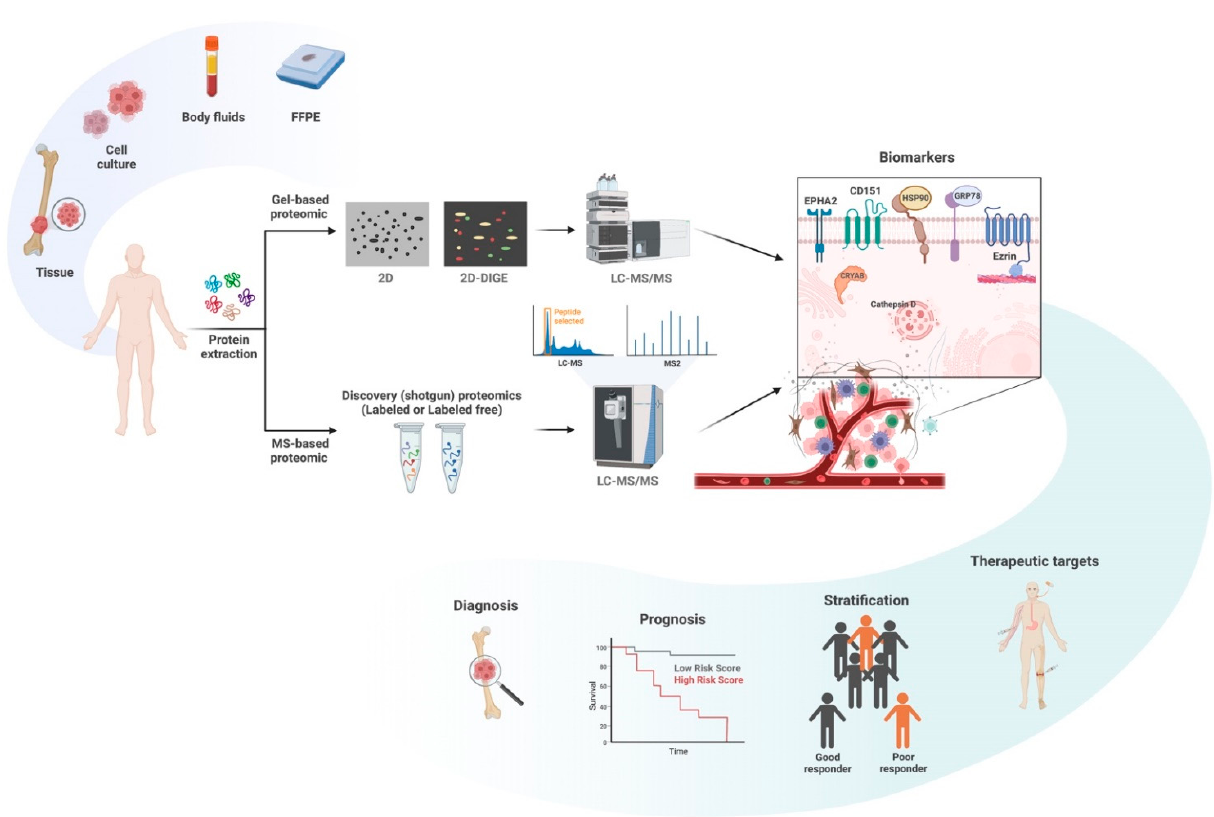
Figure 1. Workflow of the proteomic approach in osteosarcoma.